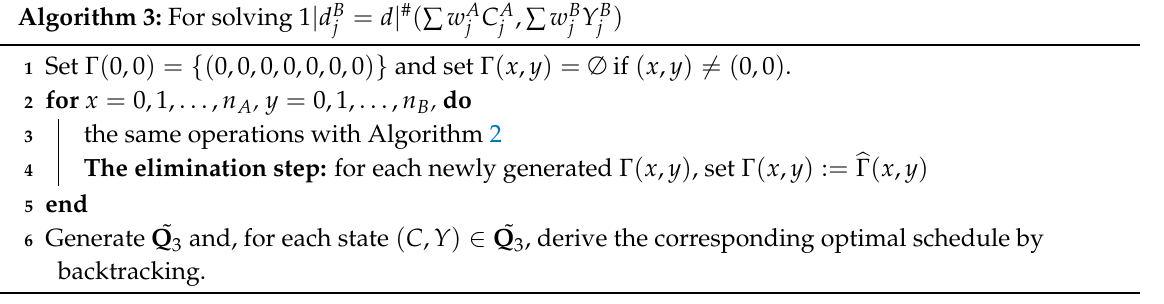
C A Y B , ∑ w B j j j j